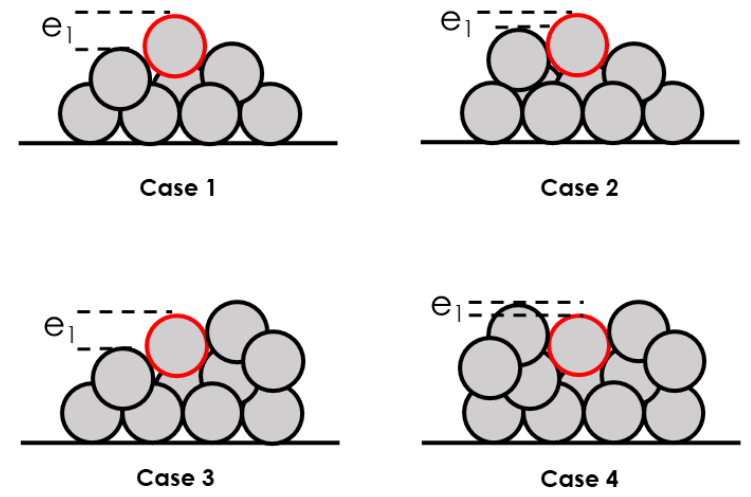
Figure 9. Influence of particle bed topography on particle entrainment. Four cases are reported here, in which the particle at entrainment is identified by red contours and e 1 represents the particle exposure: in case (1) the particle at entrainment is characterized by greater exposure with respect to case (2); in case (3) the exposure is the same as in case (1), but the presence of an obstacle downstream hampers particle entrainment—for the same particle-exposure and fluid pressure a larger impulse is needed to overcome the potential energy wall created by the protruding downstream particle. Finally, at case (4), the particle has a negative exposure and a protruding downstream particle; it will require a strong lift force, sustained in time so that its work is able to overcome the potential energy